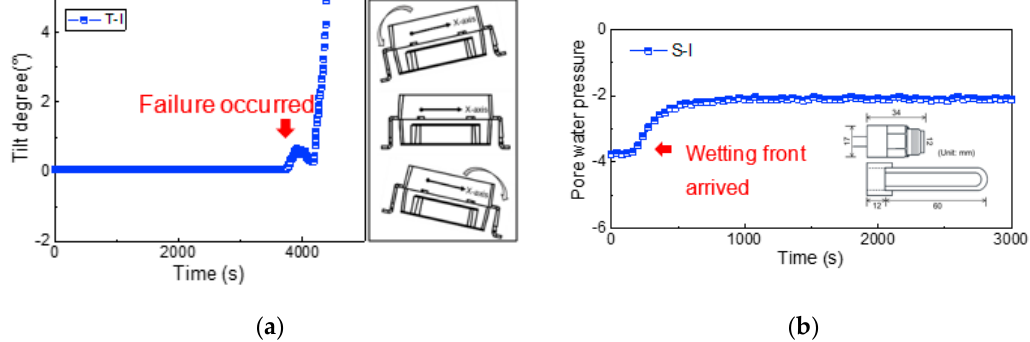
Figure 6. ( a ) MEMS (Micro-Electro-Mechanical System) tilt sensor and its working theory; ( b ) typical